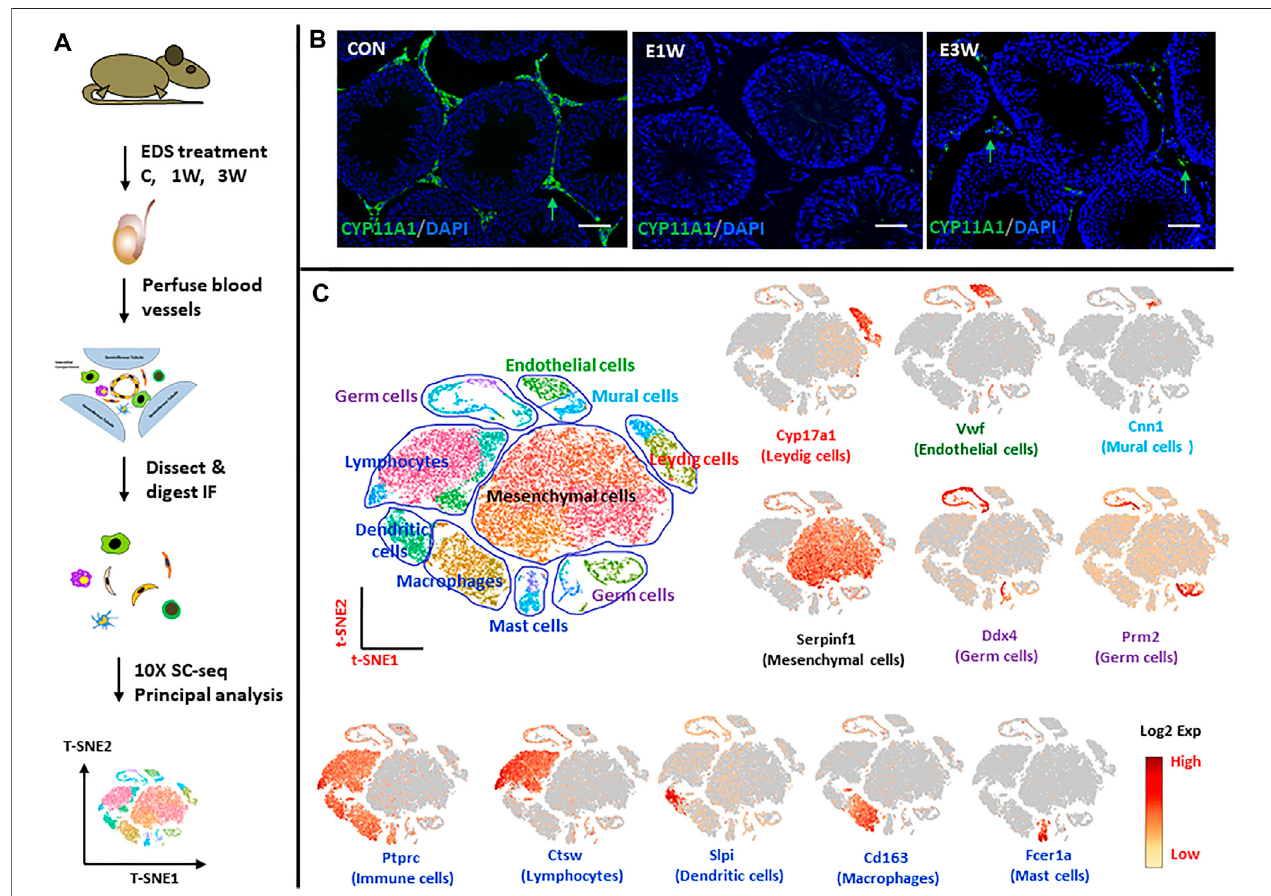
FIGURE 1 | scRNA-seq analysis of rat testicular interstitial cells before and after EDS treatment. (A) Schematic illustration of the experimental work fl ow. (B) Immuo fl uorescence staining of CYP11A1 showing the disappearance and reappearance of Leydig cells (green arrows) after EDS treatment. (C) tSNE and clustering analysis of single-cell transcriptome of the interstitial cells of control (CON; n = 11,408), 1 week (E1W; n = 7,433) and 3 weeks (E3W; n = 14,659) after EDS treatment. Each dot represents a single cell and is colored according to its origin, cell type or expression level (Log2 Exp). Typical markers for each cell type are also shown. Nine major cell types were identi fi ed. tSNE, t-distributed stochastic neighbor embedding. Bars represent 50 μ m in length.